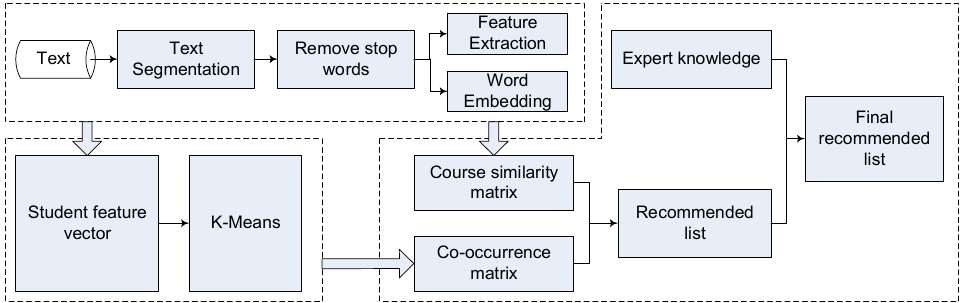
Figure 1. The workflow of the strategy proposed in this paper.